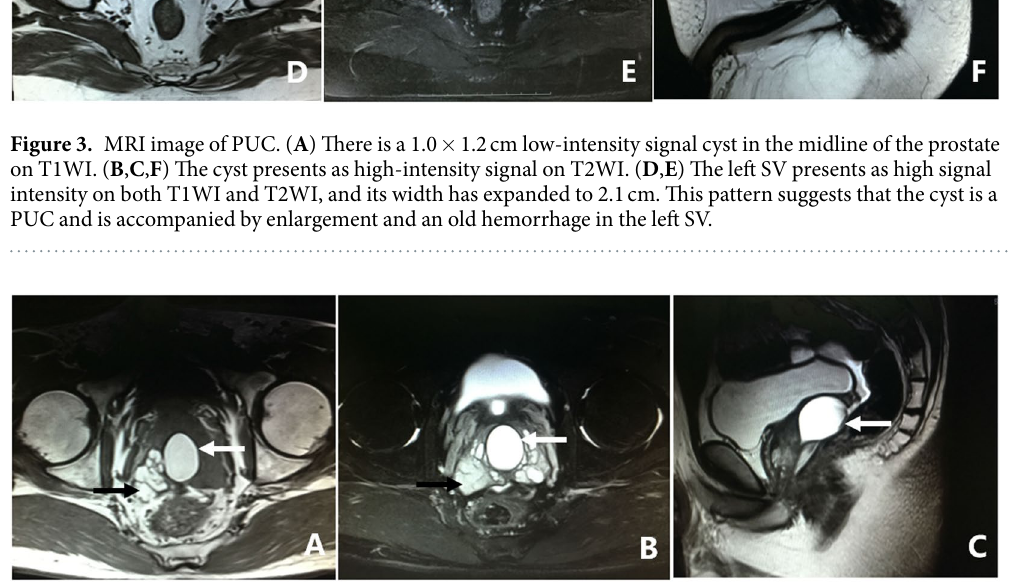
Figure 4. MRI image of MDC. ( A ) There is a 3.4 × 4.5 cm high-intensity signal cyst in the midline of the prostate, accompanied by dilation and high-intensity signals in the right SV on T1WI. ( B ) Both the cyst and the bilateral SV present as high-intensity signal on T2WI. ( C ) The cyst extended beyond the posterosuperior margin of the prostate gland on the sagittal plane. This pattern suggests that the cyst is MDC, accompanied by dilation and an old hemorrhage in the right SV.